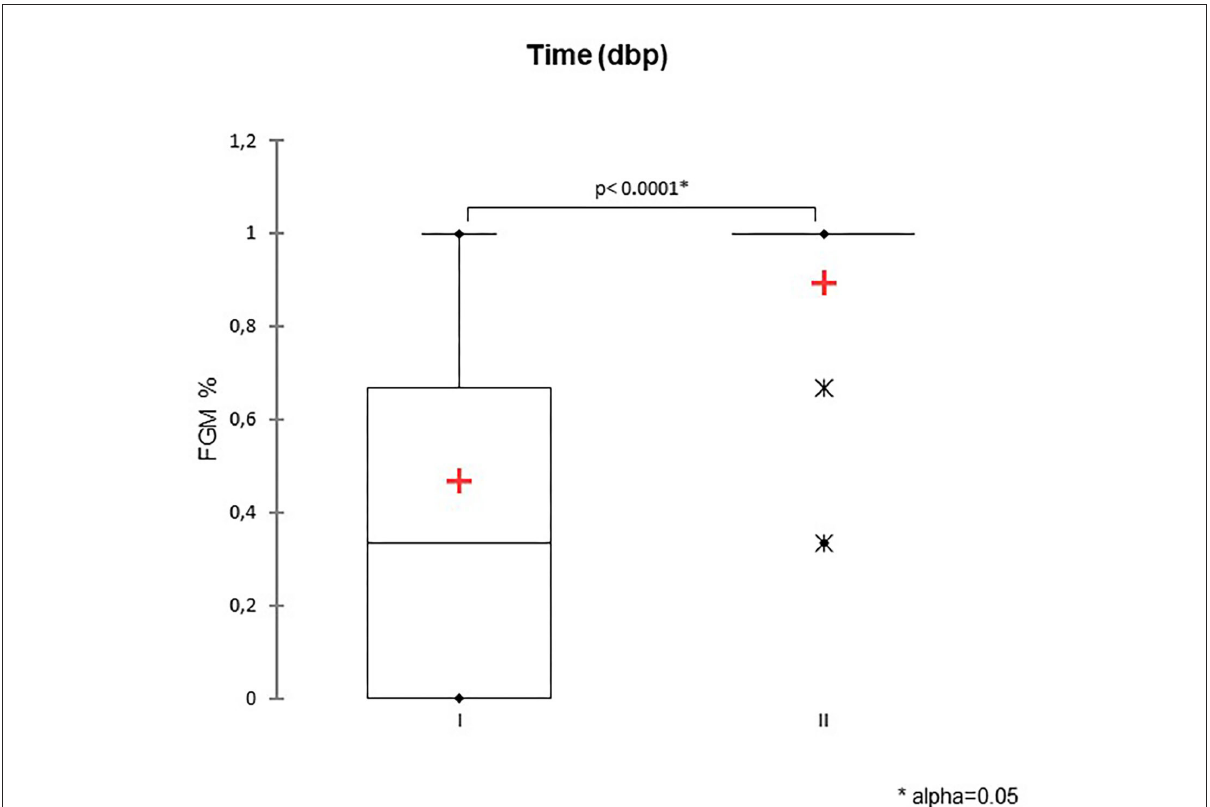
FIGURE1 The box plot reports the percentage of fetuses showing fetal gastrointestinal motility (FGM%) during two-time intervals: time I − 11/ − 5 days before parturition (DBP) and time II -4/0 DBP. Asterisk ( * ) indicates a statistically significant difference between classes ( P < 0.0001). The mean is indicated as a red cross ( +